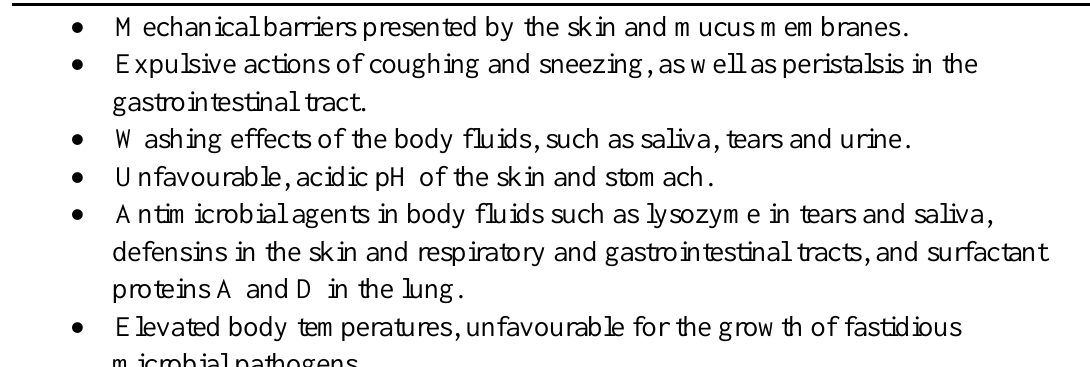
Table 1. Mechanical, physical, and chemical components of the innate immune